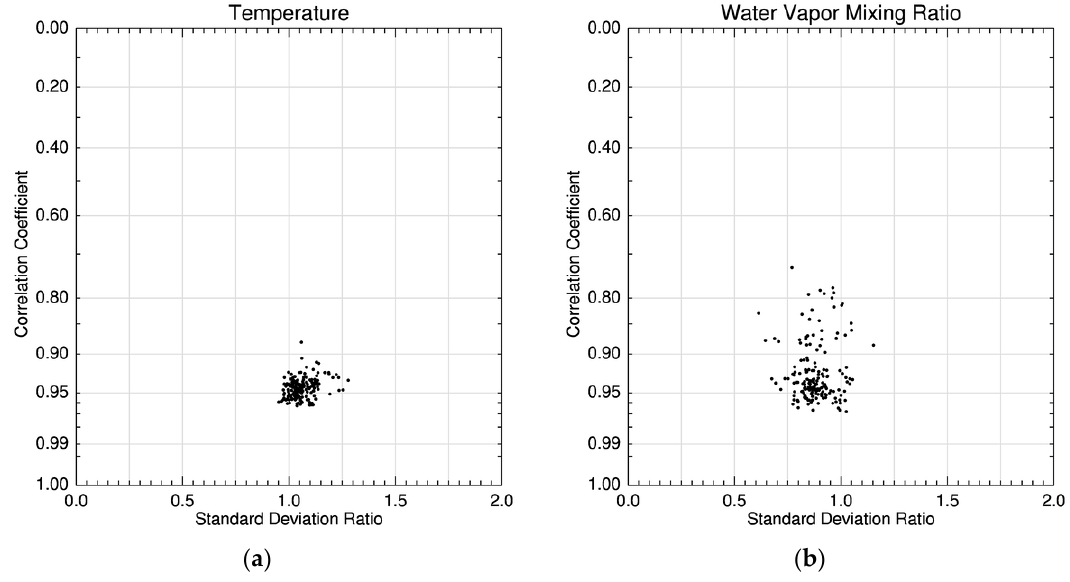
Figure 9. Modified Taylor diagrams showing the correlation coefficient and SDR between the ERA-5 data and retrieved profiles of ( a ) temperature and ( b ) water-vapor mixing ratio on 21 October 2010 at the AMY.